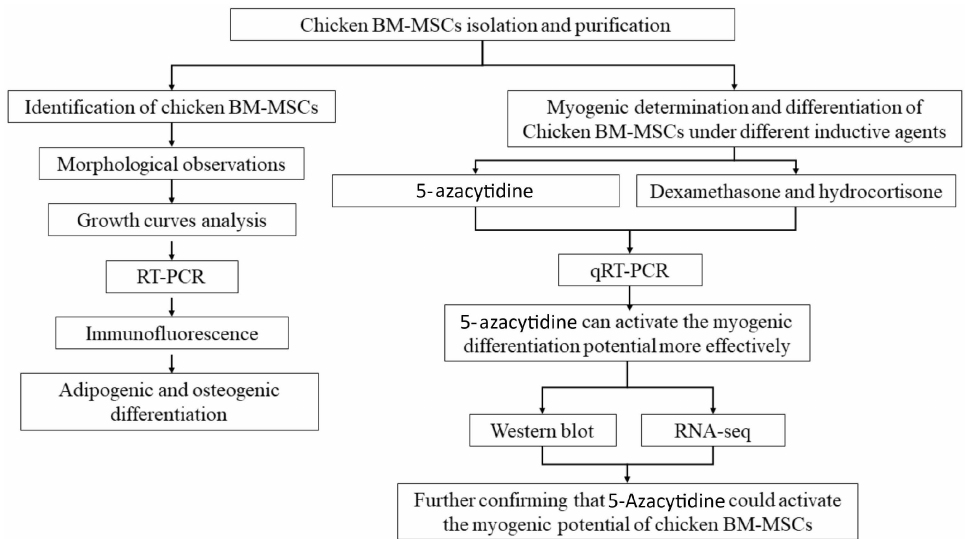
Figure 1. The experimental flow of this study. Experiments in this study can be divided into three parts, including the isolation of chicken BM-MSCs, identification of chicken BM-MSCs, and myogenic differentiation of chicken BM-MSCs under different inductive